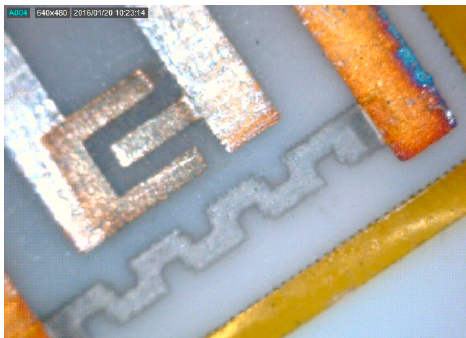
Figure 8. 200 × magnified photograph of the thin In 2 O 3 film as deposited between electrodes of the gas-sensor device.